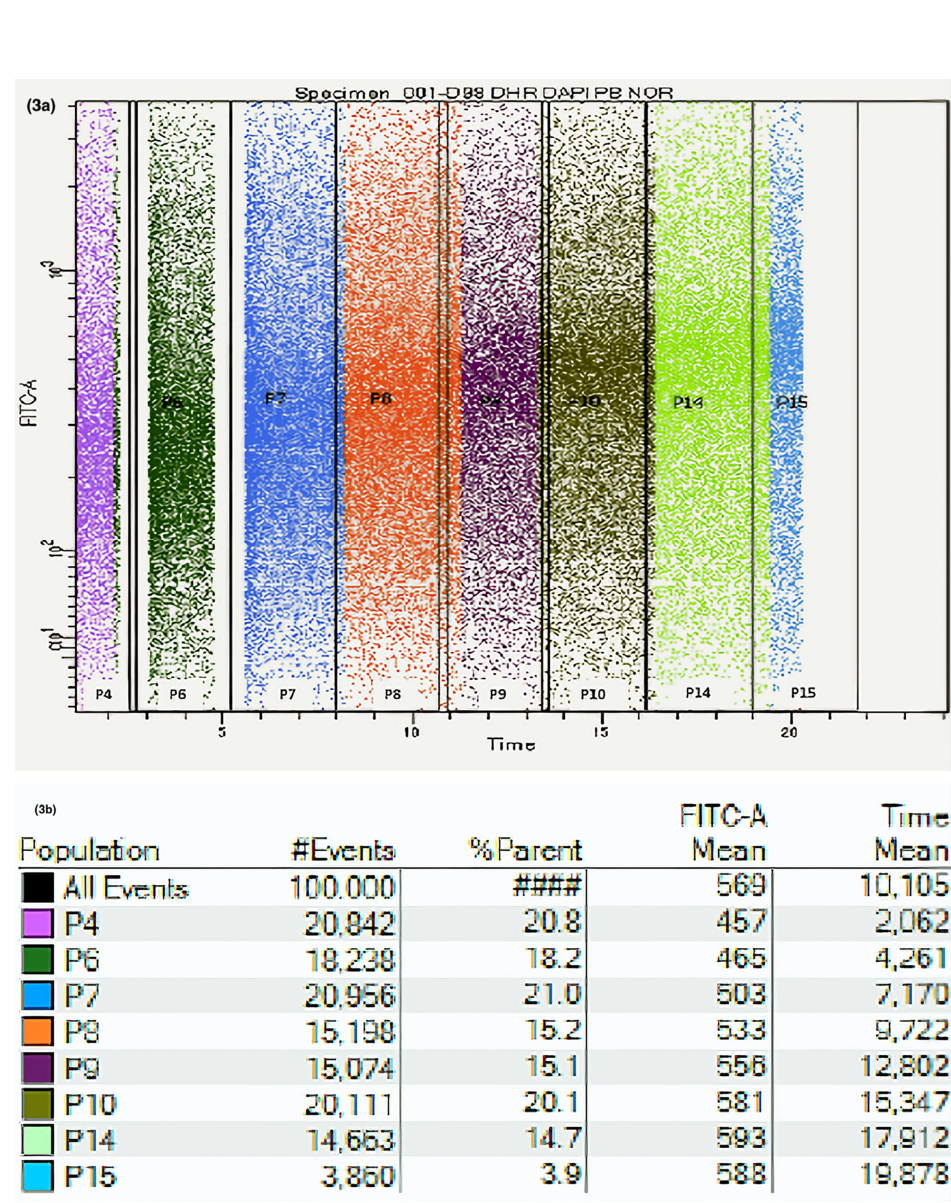
Figure 3. Flow cytometric analysis of peroxynitrite generation kinetics in nasal epithelial cells. ( a ) Dot blot acquired from kinetic measurements. Live nasal epithelial cells were gated according to FSC and SSC, and the gated events were plotted against a FITC-A channel (in this case DHR123) and time. Acquisition was paused at two points to add plumbagin (PB) (an O2- provider) and NOR-1 (a NO inductor). ( b ) Table showing gating percentages and fluorescence levels increasing over time.